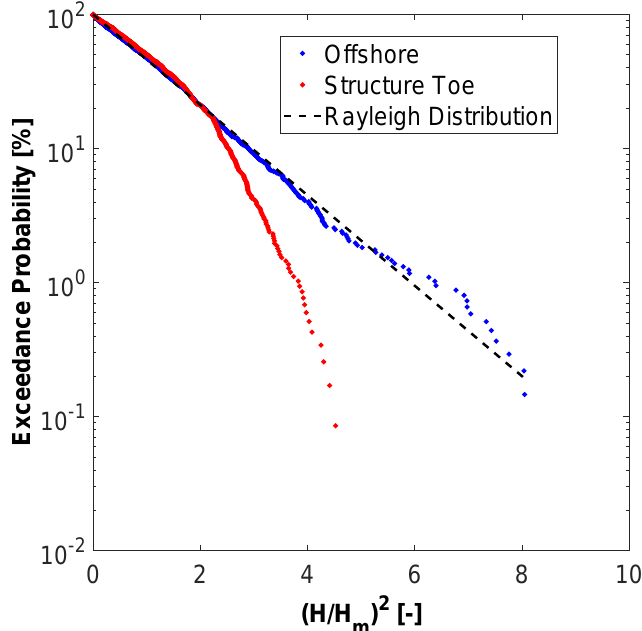
Figure 3. Distribution of the measured incident wave heights for TS 01 conditions generated by the wave paddle with comparison against expected Rayleigh